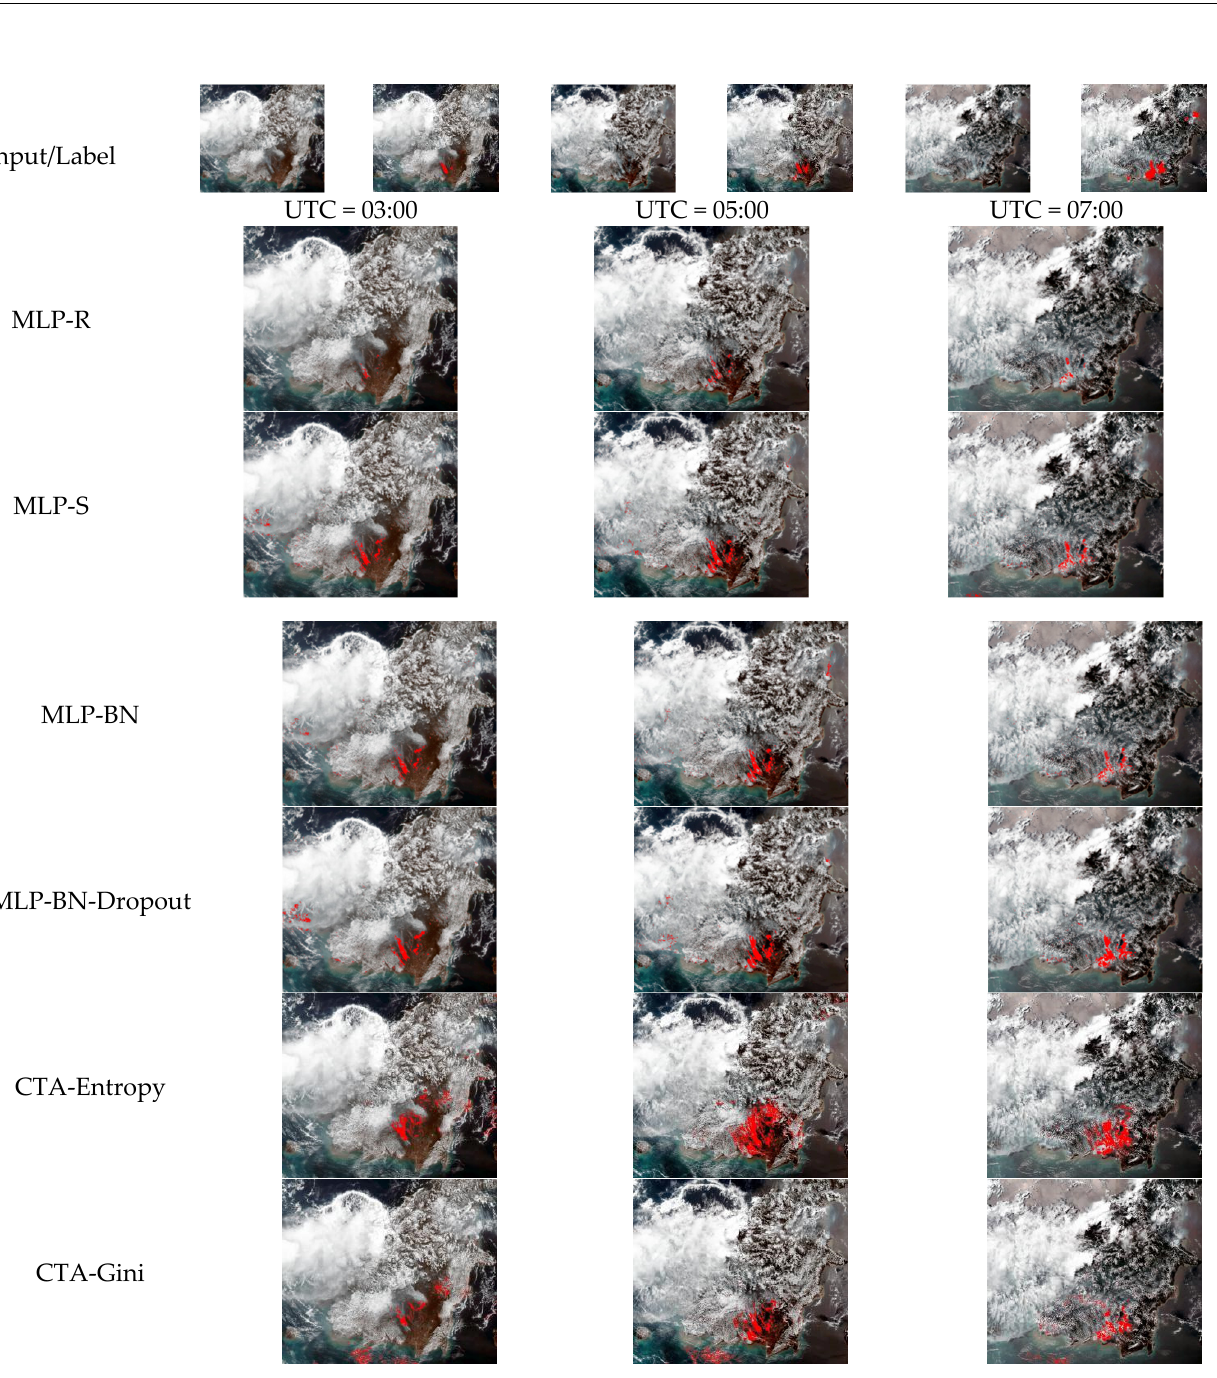
Figure 4. The visualization results are based on the histogram equalization images of test data from 30 August 2015. The first line represents the original data image of histogram equalization and the image superimposed with artificial labels (red region). The prediction results of each model are shown from the second line to the last line. The pixels marked in red in the lower six panels are the smoke pixels predicted by the model.